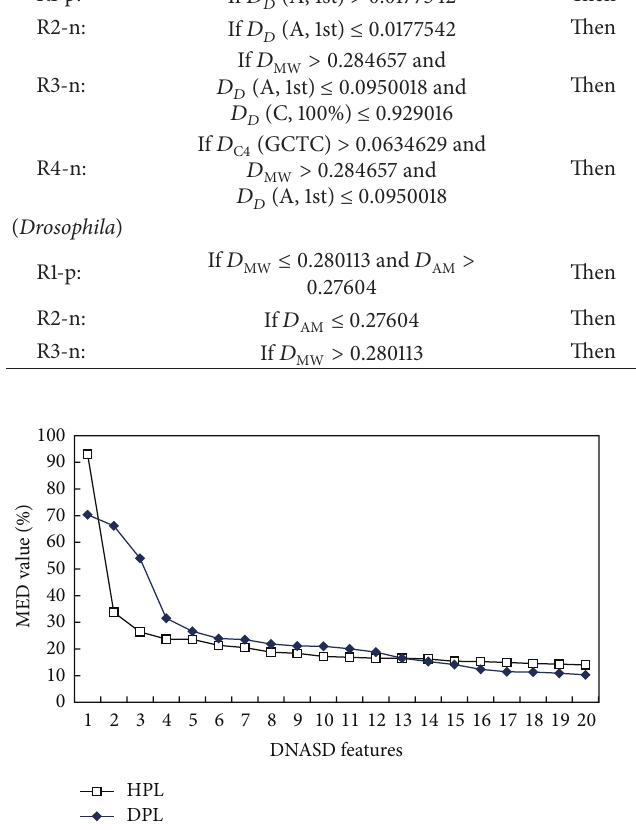
Figure 5: Top 20 DNASDs, which are ranked by MED values, for human and Drosophila training datasets. The MED values of the first two and four features exceed 30 when performing HPL and DPL datasets,